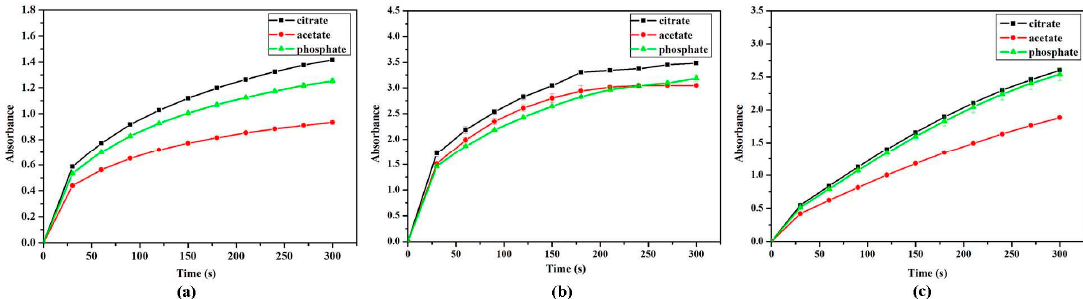
Figure 5. The effect of buffer solution on absorption value with TMB. ( a ) VO 2 nanofibers; ( b ) VO 2 nanosheets; ( c ) VO 2 nanorods. The error bars represent the standard deviation of three measurements.